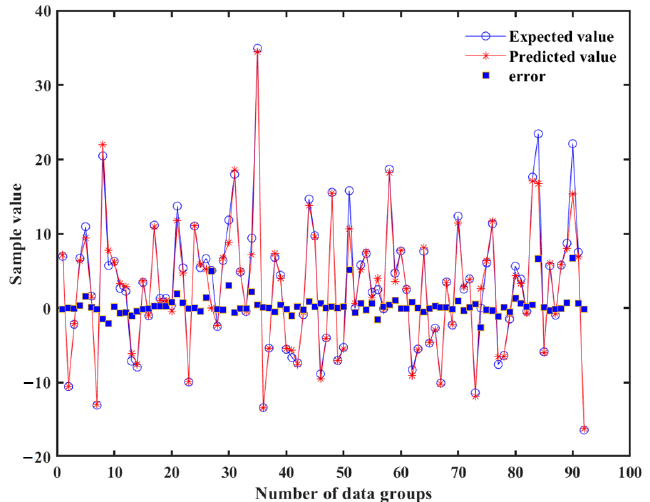
Figure 12. Comparison of predicted values and expected values of the BP neural network test set.